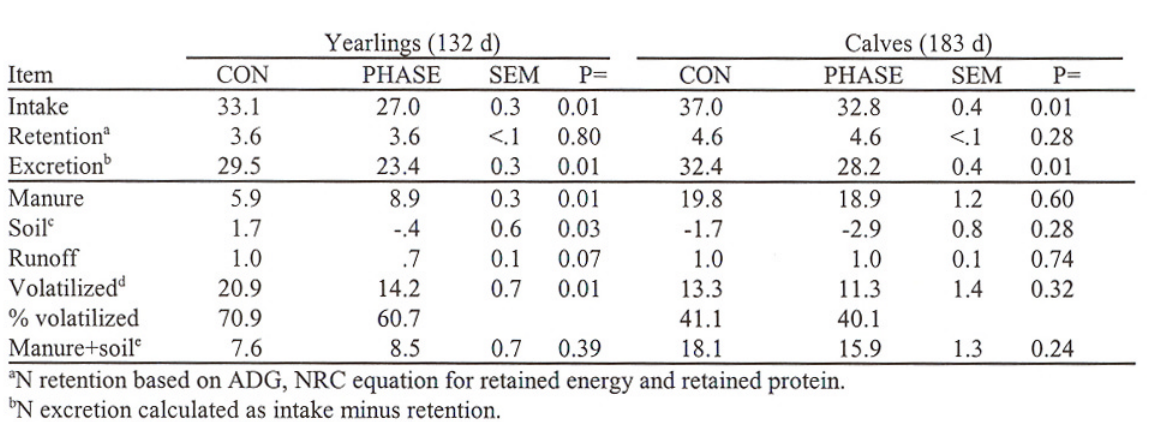
N Balance in the Feedlot for the Yearling and Calf Experiments Separated by Dietary Treatment (All Values Expressed as kg per Steer over the Entire Feeding